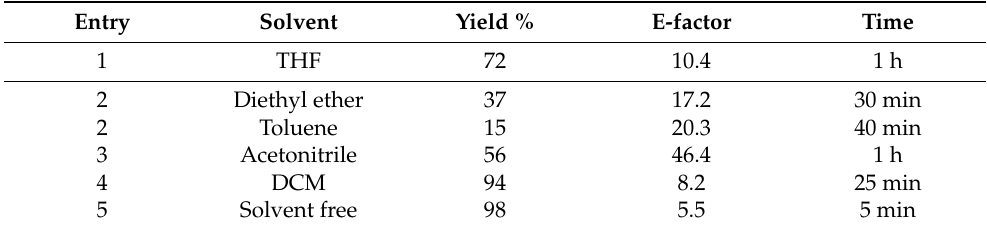
Table 1. Solvent test for the dehydration of N -(3-bromophenyl)formamide with POCl 3 and a base. Entry Solvent Yield % E-factor